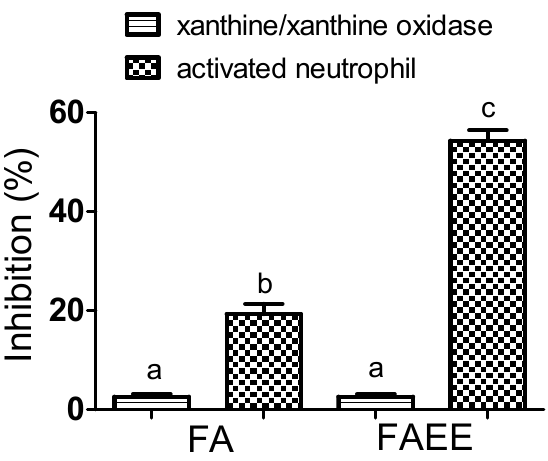
Figure 5. Inhibitory effect on superoxide anion produced by stimulated neutrophils and by xanthine/xanthine oxidase (X/XO). The production of superoxide was monitored by the reduction of WST-1. The tested compounds were used at 100 µM in both assays. The results are mean and SD of duplicates of three different experiments. Different letters